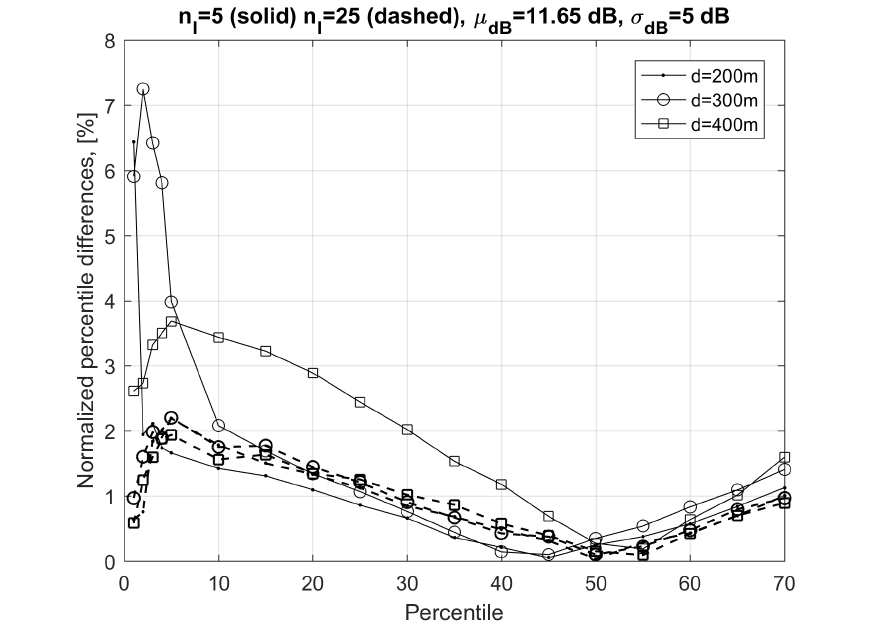
Figure 5. Normalized differences among percentiles (percentage of the corresponding bit